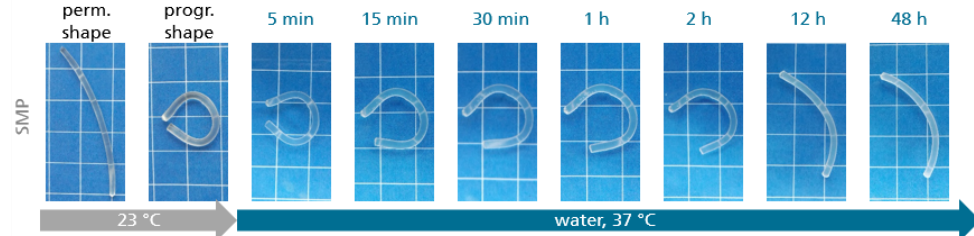
Figure 5. Water-responsiveness of a piece of filament from PPG-based TPU. From left to right: per- manent shape at 23 °C, temporary shape at 23 °C, time-lapse activation of the shape memory effect in 37 °C water. For visualization, centimeter paper is shown in the background of the individual